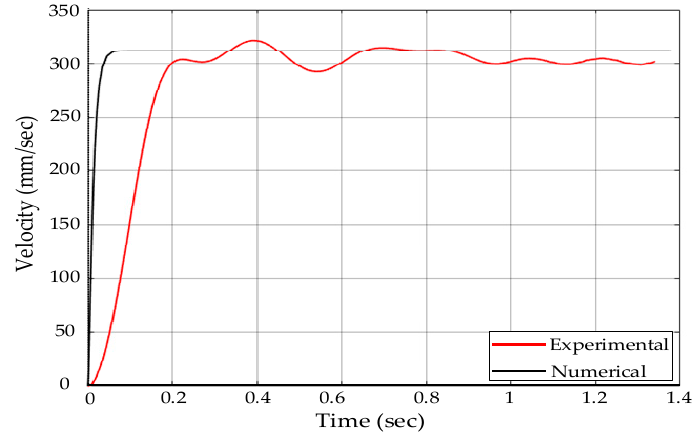
Figure 18. Time variations of velocities for simulation and experiment.